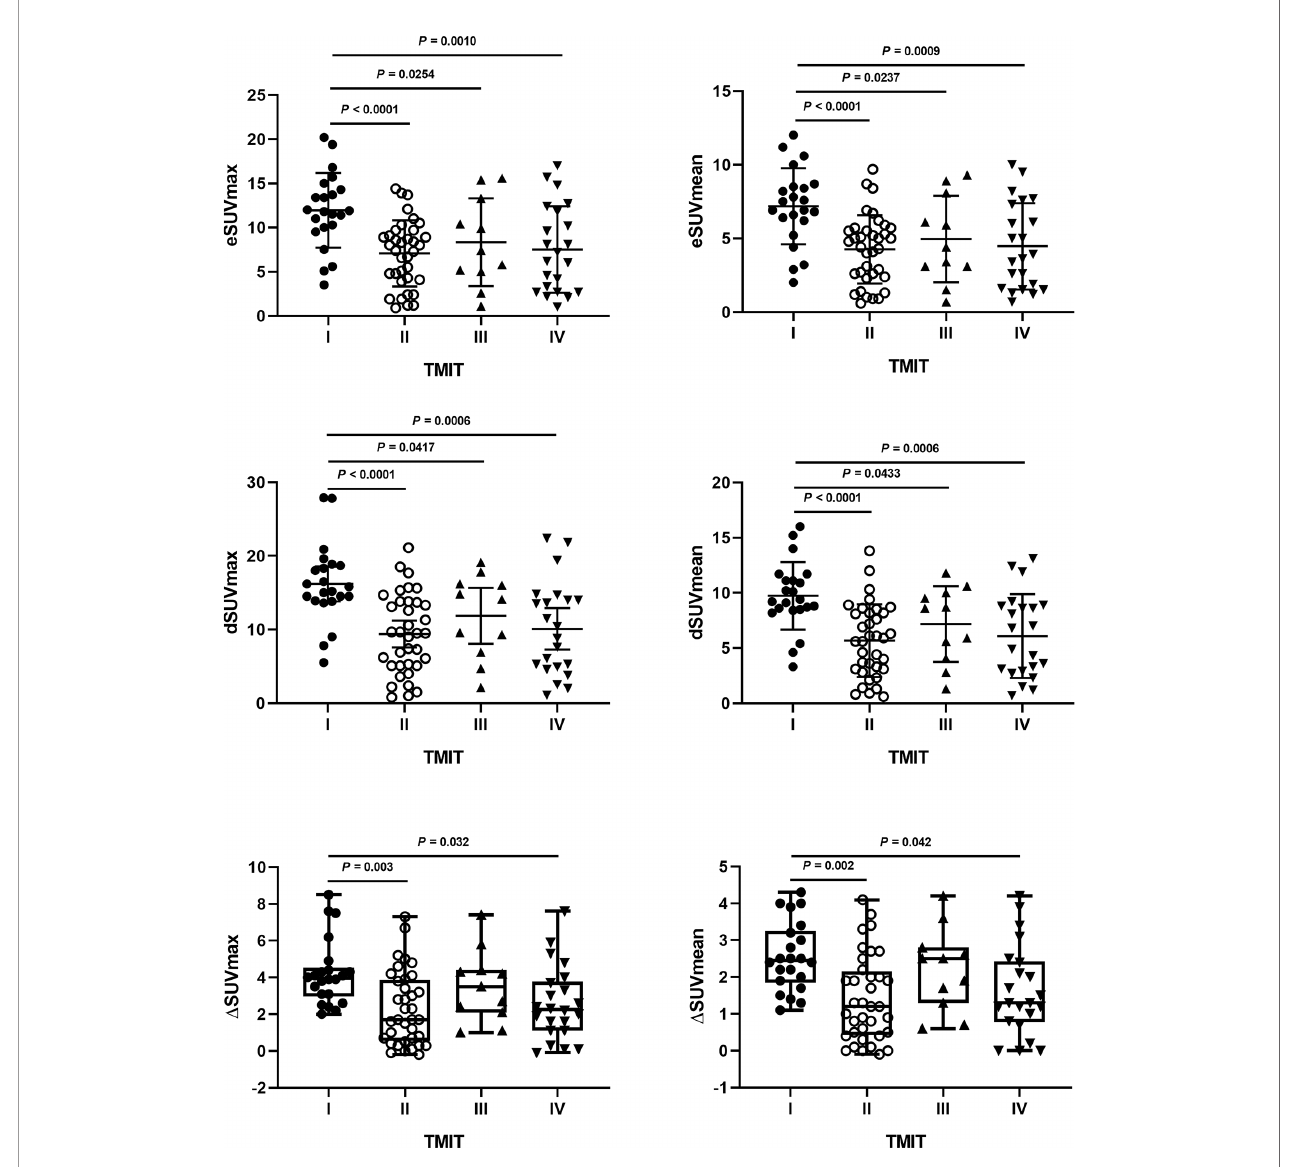
FIGURE 4 | The differences of metabolic parameters (MPs) according to different tumor microenvironment immune types (TMITs). The MPs were signi fi cantly higher in TMIT I tumors than other immune